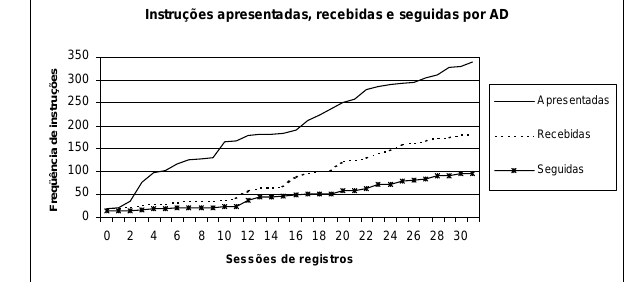
Figura 2. Freqüência acumulada dos tipos de instruções apresentadas pe- las três crianças no período de Levantamento do Repertório de Entrada (sessão 0) e ao longo das 31 sessões de coleta de dados.